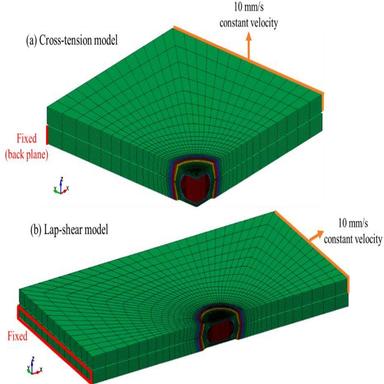
Mesh plots showing the boundary conditions for (a) half-symmetry lap-shear, and (b) quarter-symmetry cross-tension models.